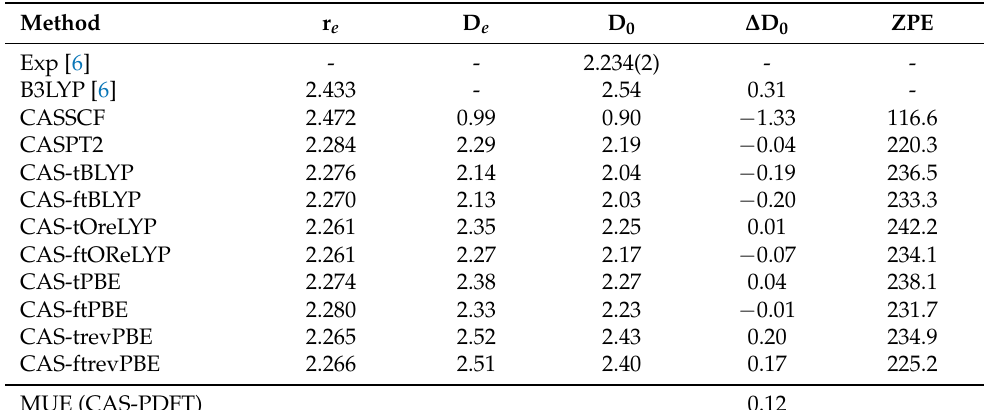
Table 4. Dissociation energies (eV), equilibrium bond lengths (Å), and zero point energies (in cm − 1 ) for VSi in the 4 Π molecular state, computed with a CASSCF wave function. Method